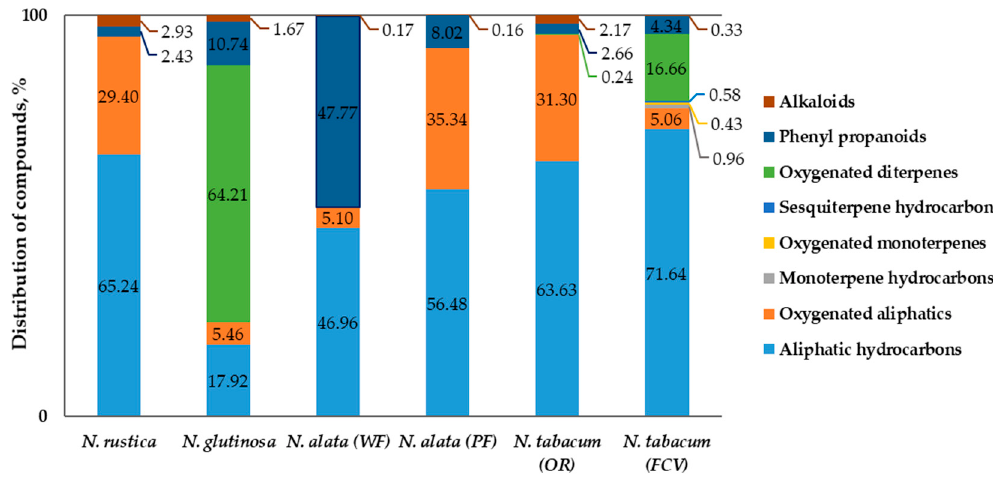
Figure 1. Profile of Nicotiana flower concretes (the sum of identified compounds = 100%); N. alata (WF) -genotype with white flowers; N. alata (PF) -genotype with pink flowers; N. tabacum (OR) -Oriental type; N. tabacum (FCV) -flue-cured Virginia type.